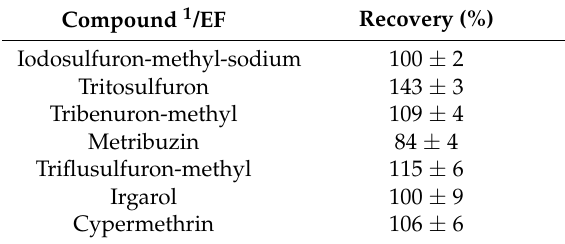
Table 5. Recoveries obtained for real a seawater sample spiked with the target herbicides ( n = 3).